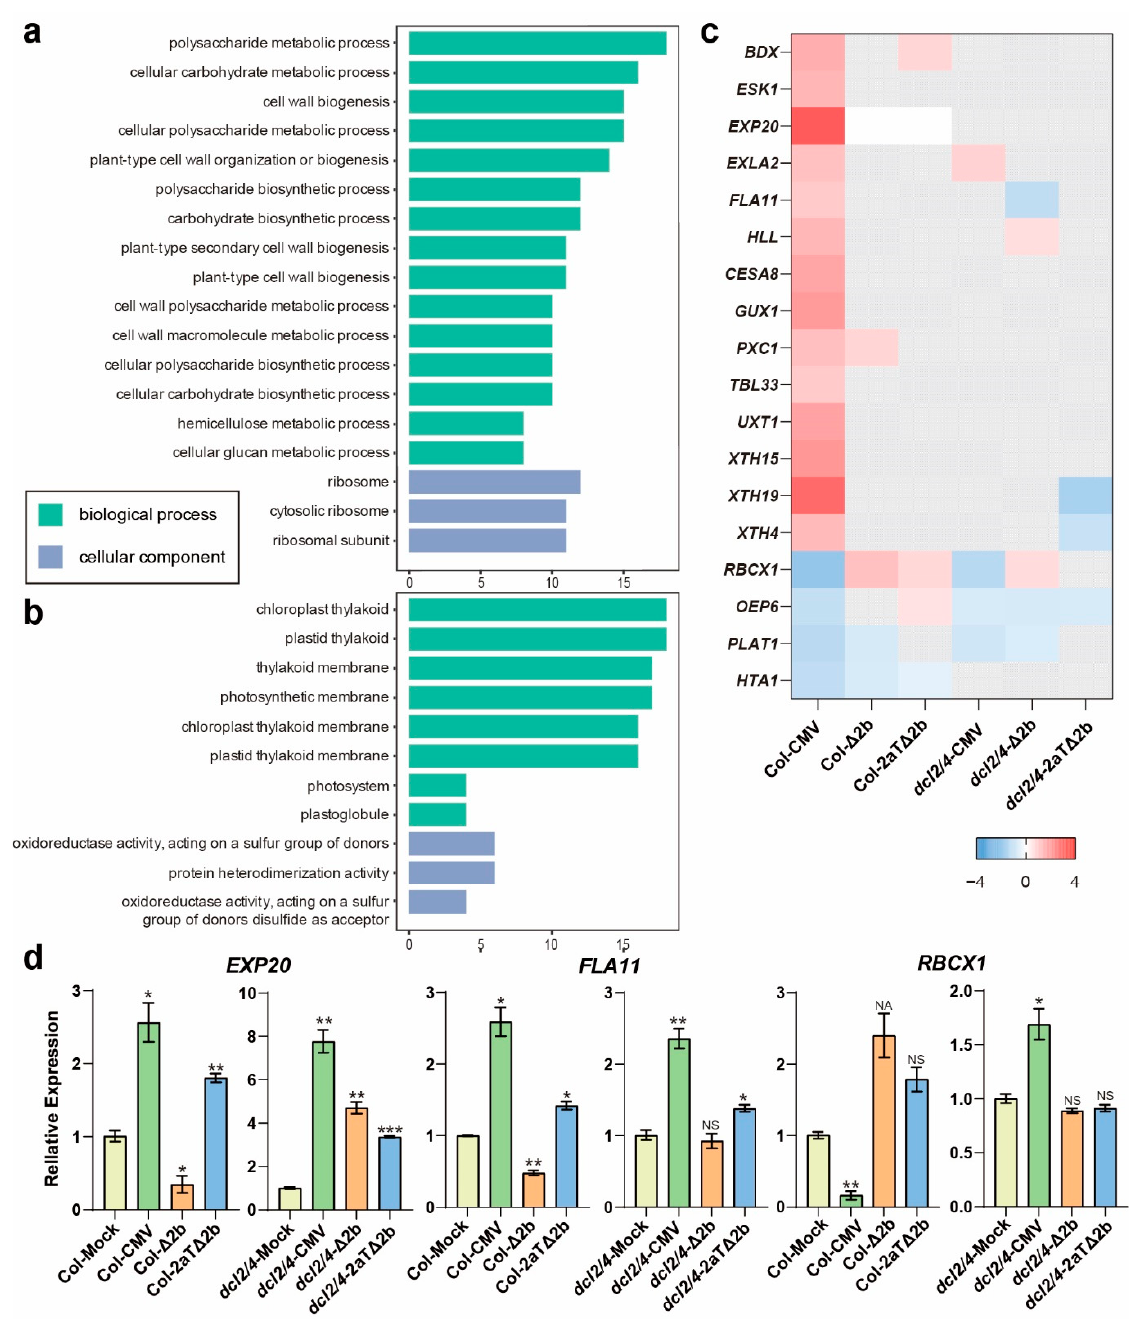
Figure 4. DEGs specifically detected in Col-CMV. ( a ) GO terms enriched for induced DEGs. ( b ) GO terms enriched for suppressed DEGs. The y-axis represents the enriched GO term, and the x-axis represents the number of DEGs in the term. Different colors are used to distinguish biological processes, cellular components and molecular functions. ( c ) Heat map of DEGs enriched in GO terms. ( d ) Relative transcriptional level of EXP20 , FLA111 , and RBCX1 . Values are means ± SEM. *, P < 0.05; **, P < 0.01; ***, P < 0.001; NS, no significance (n = 3, two-tailed Student’s t -test). Simultaneously, suppressed genes are involved in chloroplast thylakoid (GO:0009534, chloroplast thylakoid; GO:0031976, plastid thylakoid; GO:0042651, thylakoid membrane; GO:0034357, photosynthetic membrane; GO:0009535, chloroplast